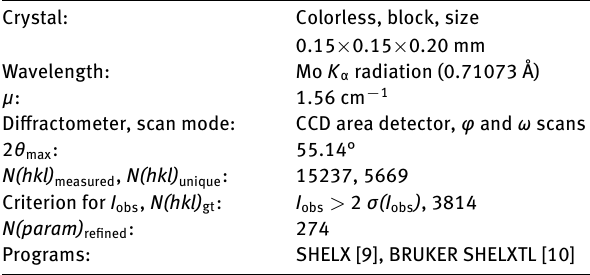
Table 1: Data collection and handling.